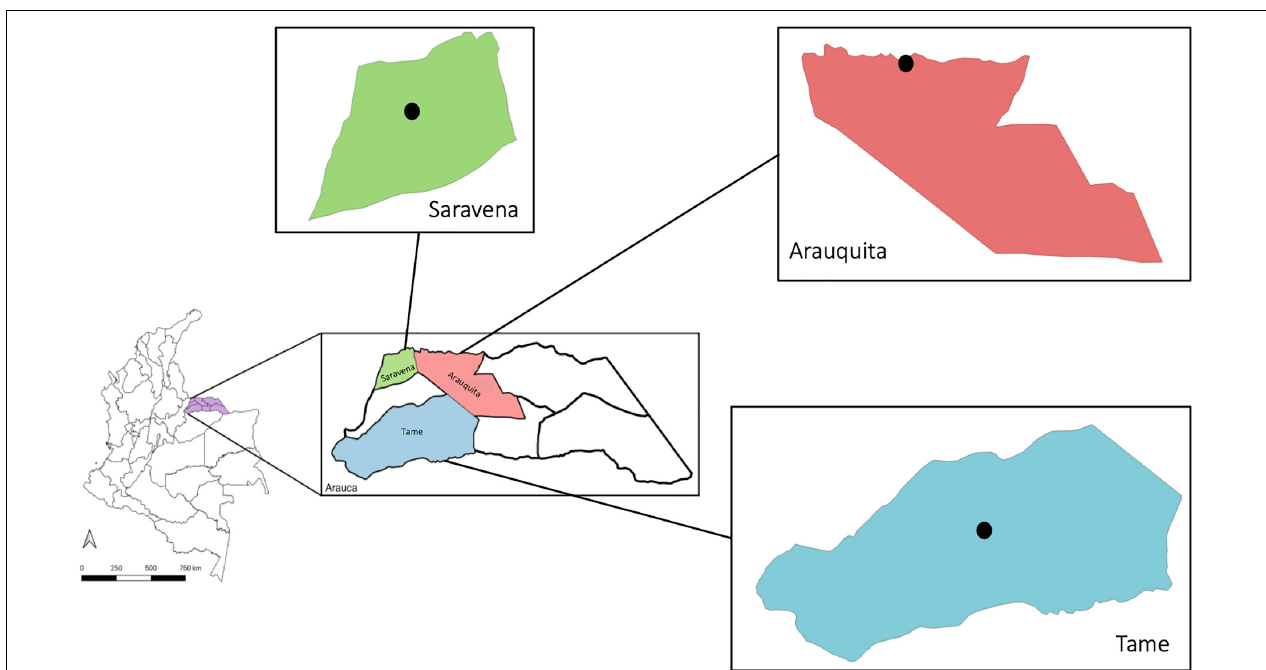
FIGURE 1 | Municipalities where captures were conducted: Saravena (green), Arauquita (pink), and Tame (blue) in the department of Arauca (purple), Colombia. The black dot indicates the urban area where the capture of individuals was